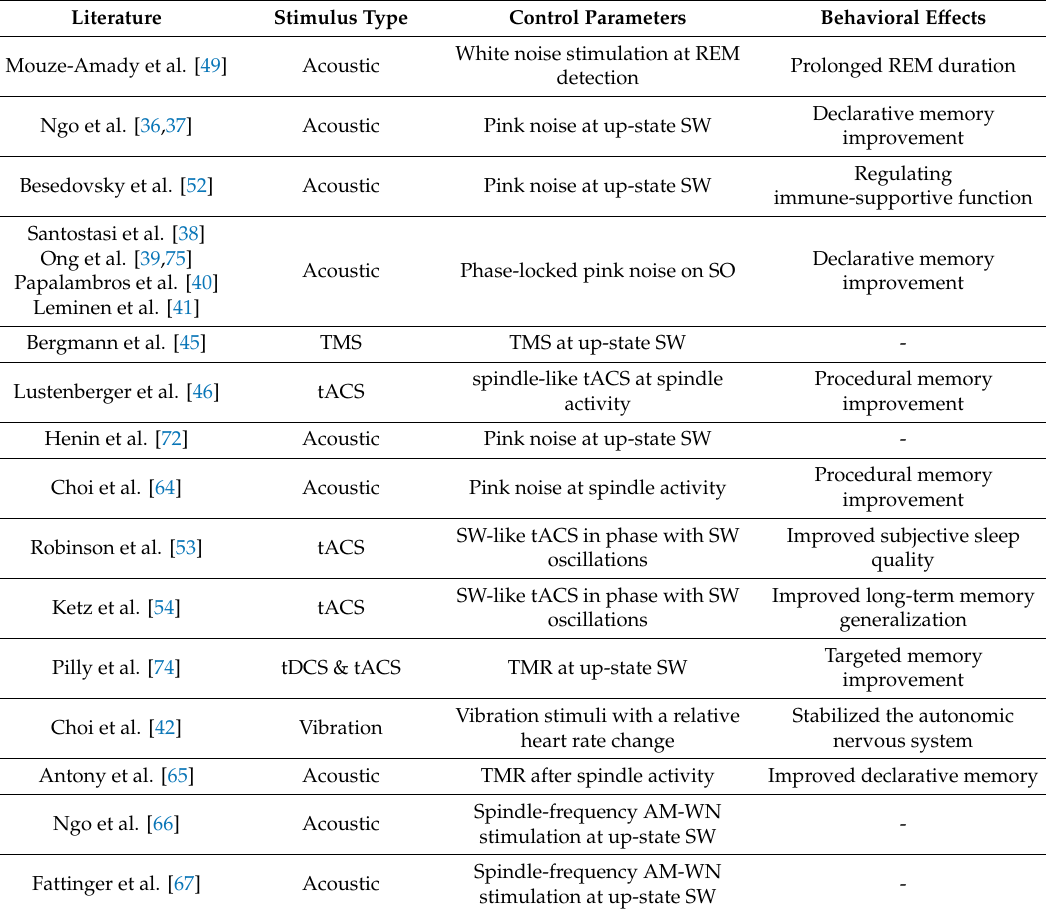
Table 1. Sleep studies with closed-loop feedback systems.